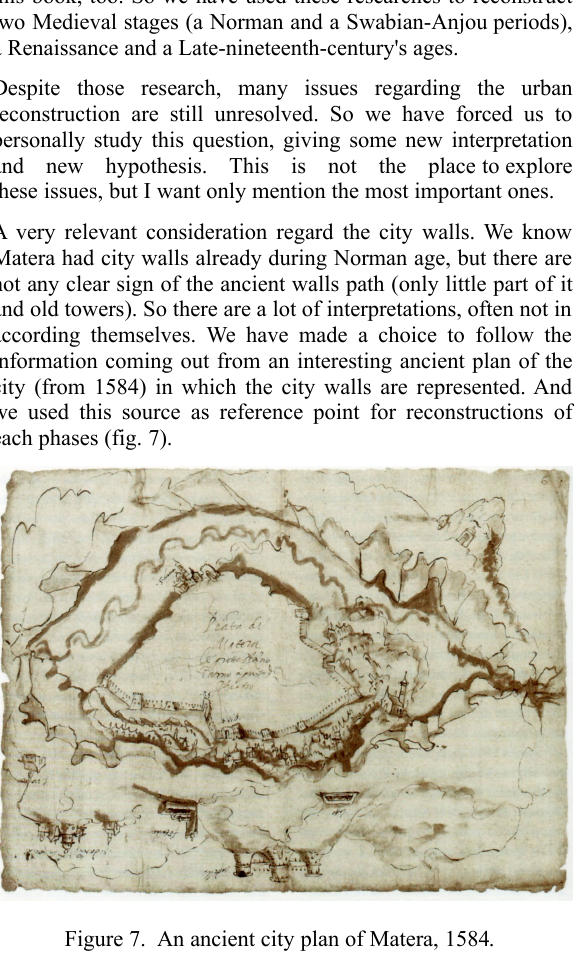
Figure 7. An ancient city plan of Matera,